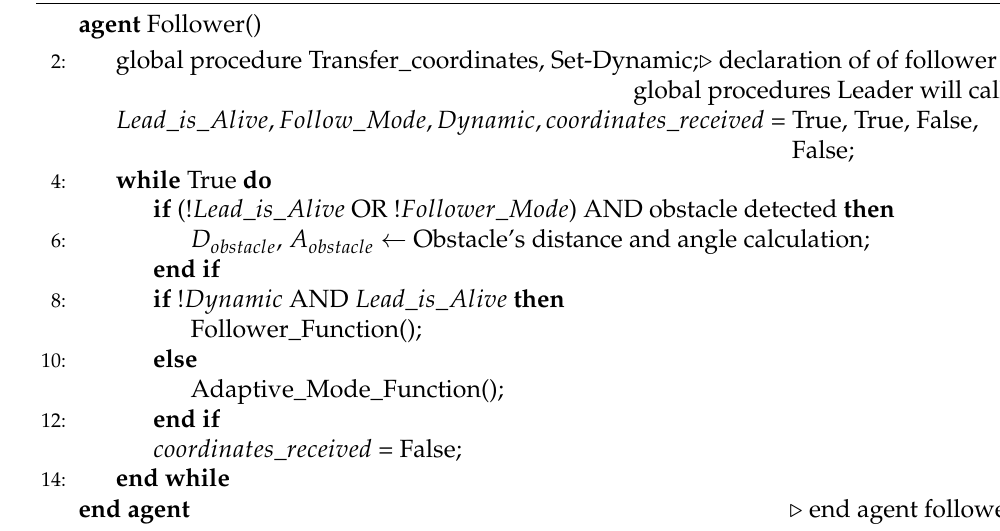
Algorithm 2 Follower: Navigation & Object Detection agent Follower()